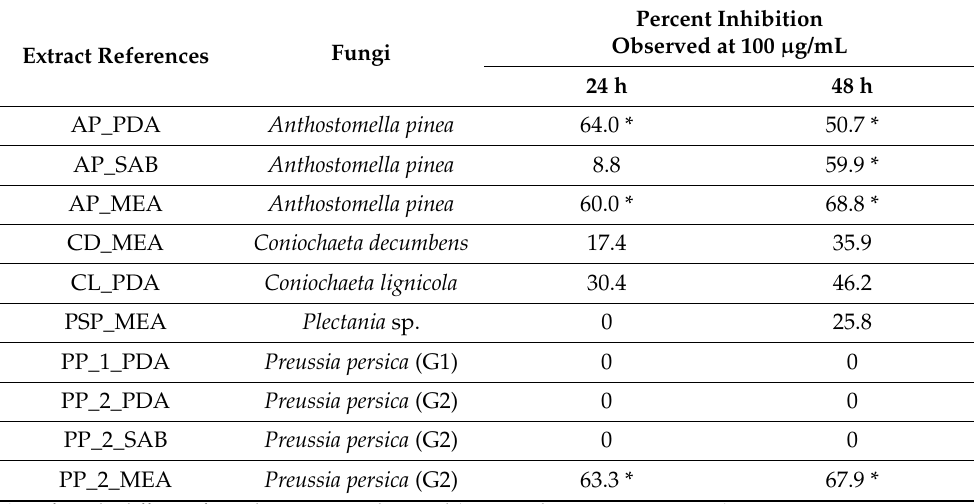
Figure 1. Total quantity of crude fungal extracts obtained from the three culture media. Table 2. Anti-biofilm activity of endolichenic fungal extracts at 100 µ g/mL on biofilm of C. albicans ATCC 28367. Extracts were added on a 24 h-old biofilm. The contact duration between biofilm and extracts was 24 h or 48